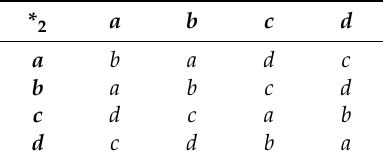
Table 10. The operation * 2 on commutative perfect NETG N 2 .